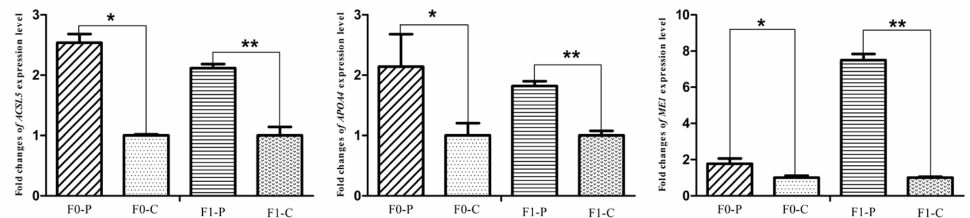
Figure 10. Fold changes of fatty acid metabolism gene ( ACSL5 ), lipid metabolism gene ( APOA4 ) and glucose metabolism gene ( ME1 ) expression levels between P (paternal inheritance group) and C (control group) in the F0 and F1 generations. * indicates p < 0.05 and ** indicates p < 0.01.